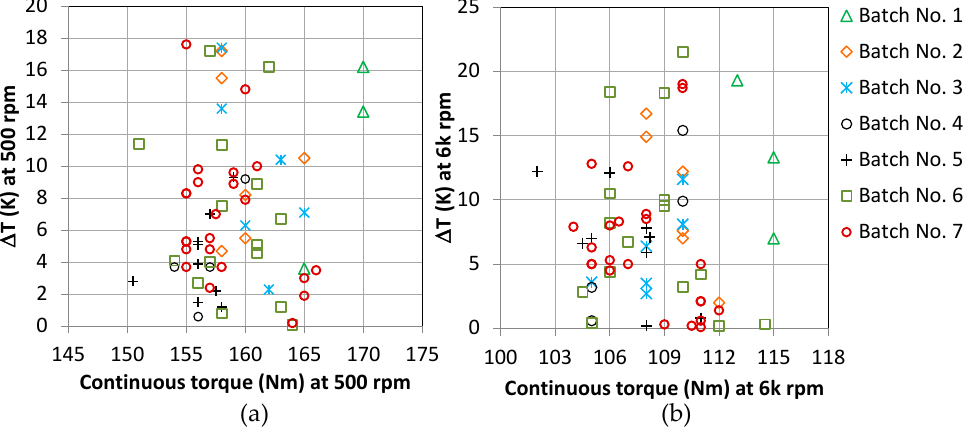
Figure 8. Temperature differences between winding stators vs. continuous torque at two different speeds: ( a ) 500 rpm; ( b) 6000 rpm.